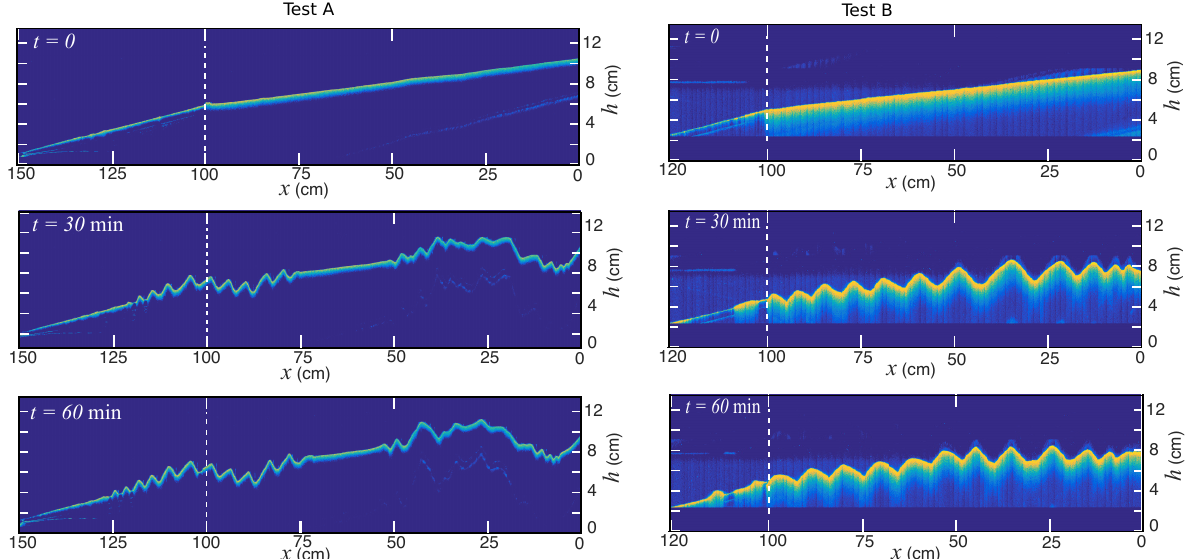
Figure 12. Experimental results of the bathymetry evolution for Test A and B. The dash line refers to the division between the rigid and mobile bed